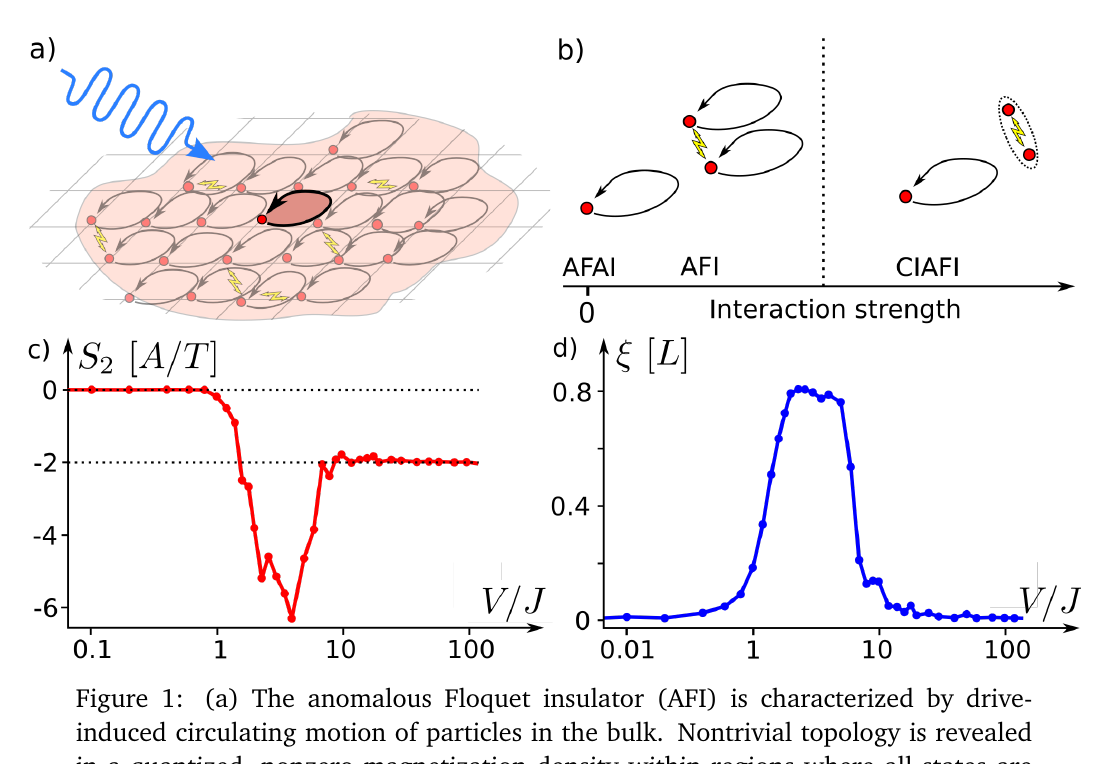
Figure 1: (a) The anomalous Floquet insulator (AFI) is characterized by drive- induced circulating motion of particles in the bulk. Nontrivial topology is revealed in a quantized, nonzero magnetization density within regions where all states are µ 1 filled, given by 〈 m 〉 = , where µ is a nonzero integer. (b) With sufficiently 1 T